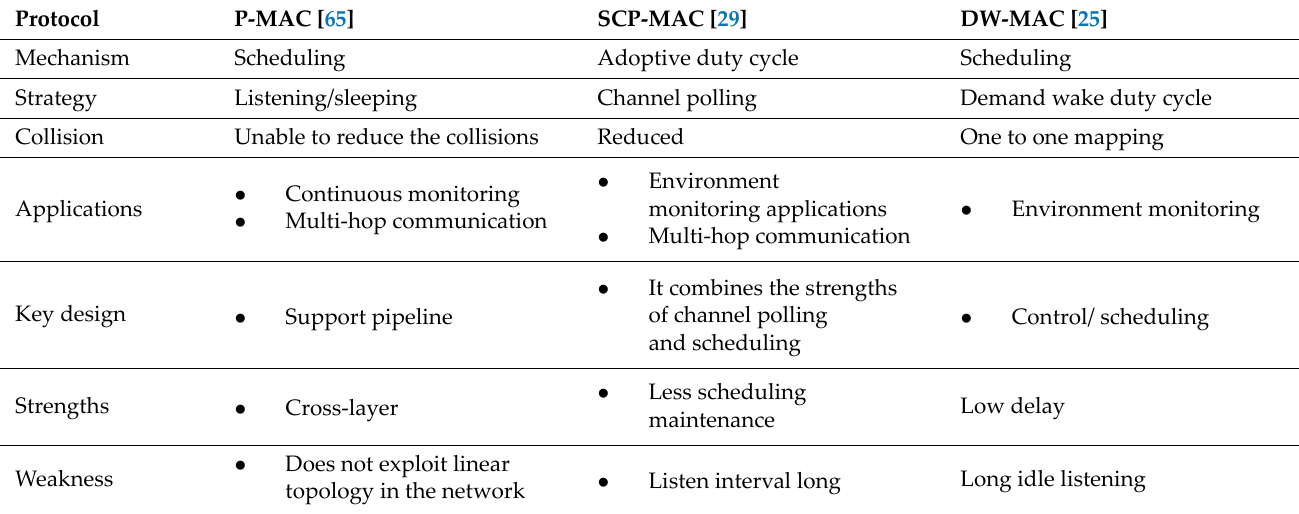
Table 6. Key The synchronous duty cycle protocols